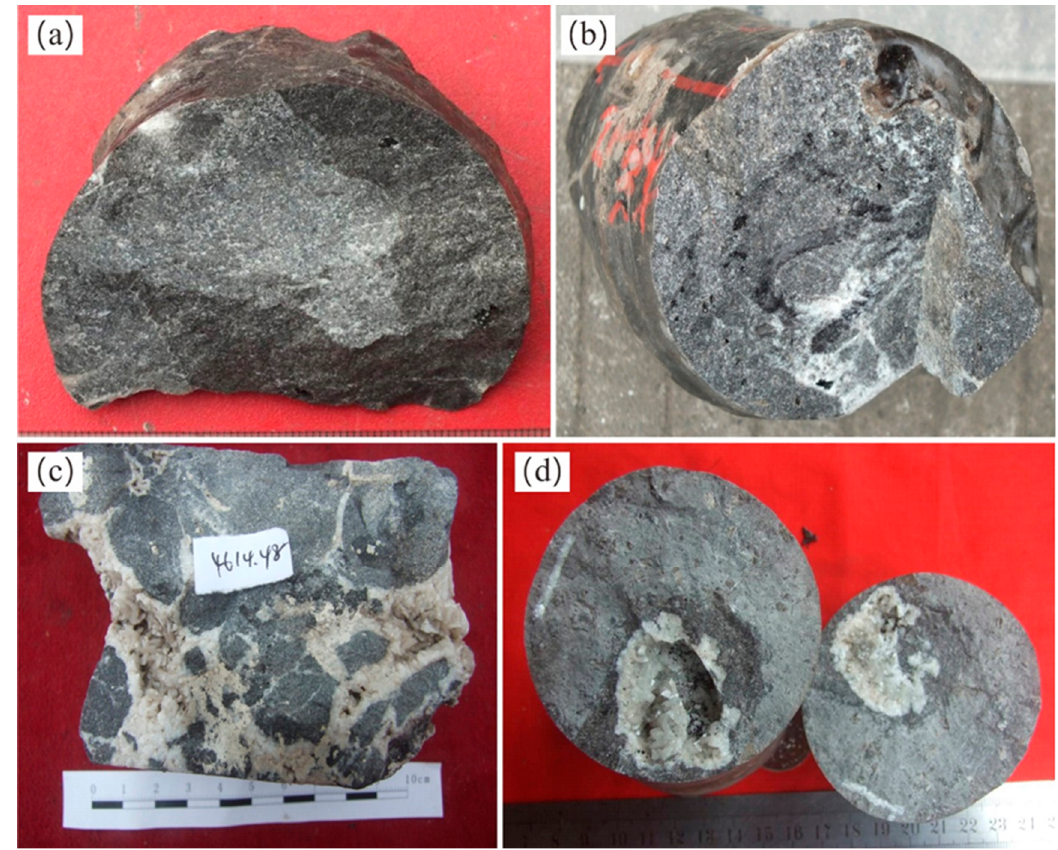
Figure 4. Typical core photo of the dolomite reservoir in the study area. ( a ) The dense gray-black limestone on the top of the Maokou Formation (P 1 m 3 ); ( b ) The top part of Mao 2 Member (P 1 m 2 a) is gray and gray-brown dolomite, with dissolved pores and faults visible; ( c ) The middle (P 1 m 2 b) gray and gray-brown dolomite in the middle part of the Mao 2 Member, with full and semifilled mesh joints of dolomite; ( d ) Gray and gray-brown vermiculite combined with limestone at the bottom of Mao 2 Member (P 1 m 2 c).